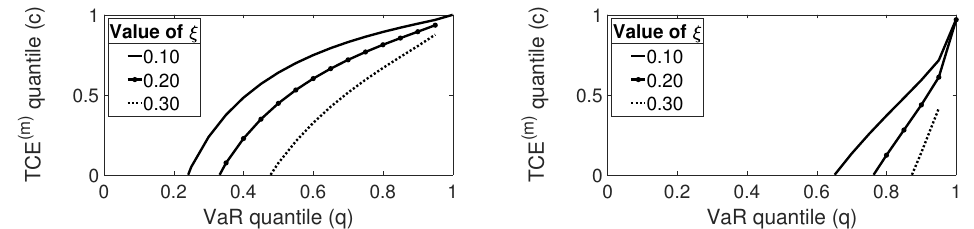
Figure 5. Extended TCE quantile as a function of VaR quantile. ( Left panel ): m = 2, σ = 0.1, and µ = 0. ( Right panel ): m = 2, σ = 0.4, and µ = 0.